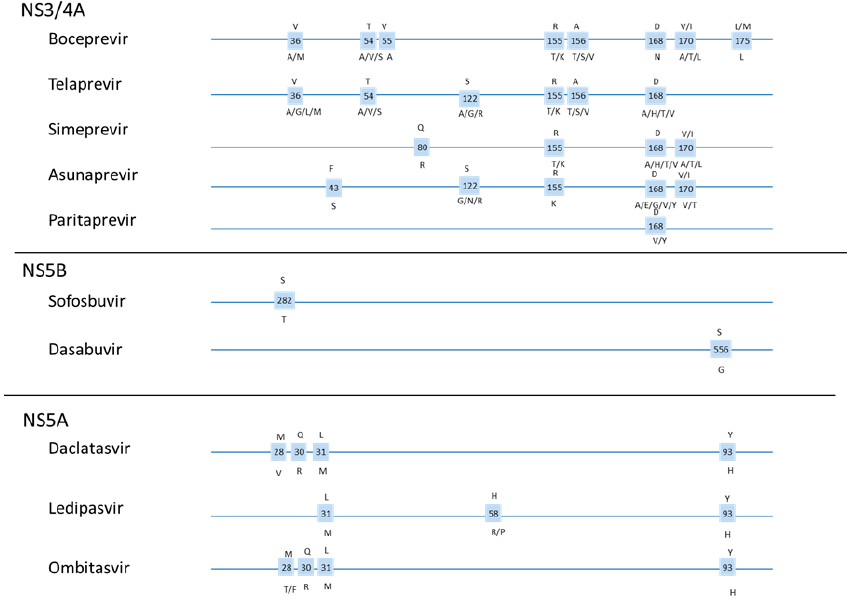
Figure 2. Position of frequently reported resistance mutations for selected DAAs [12].